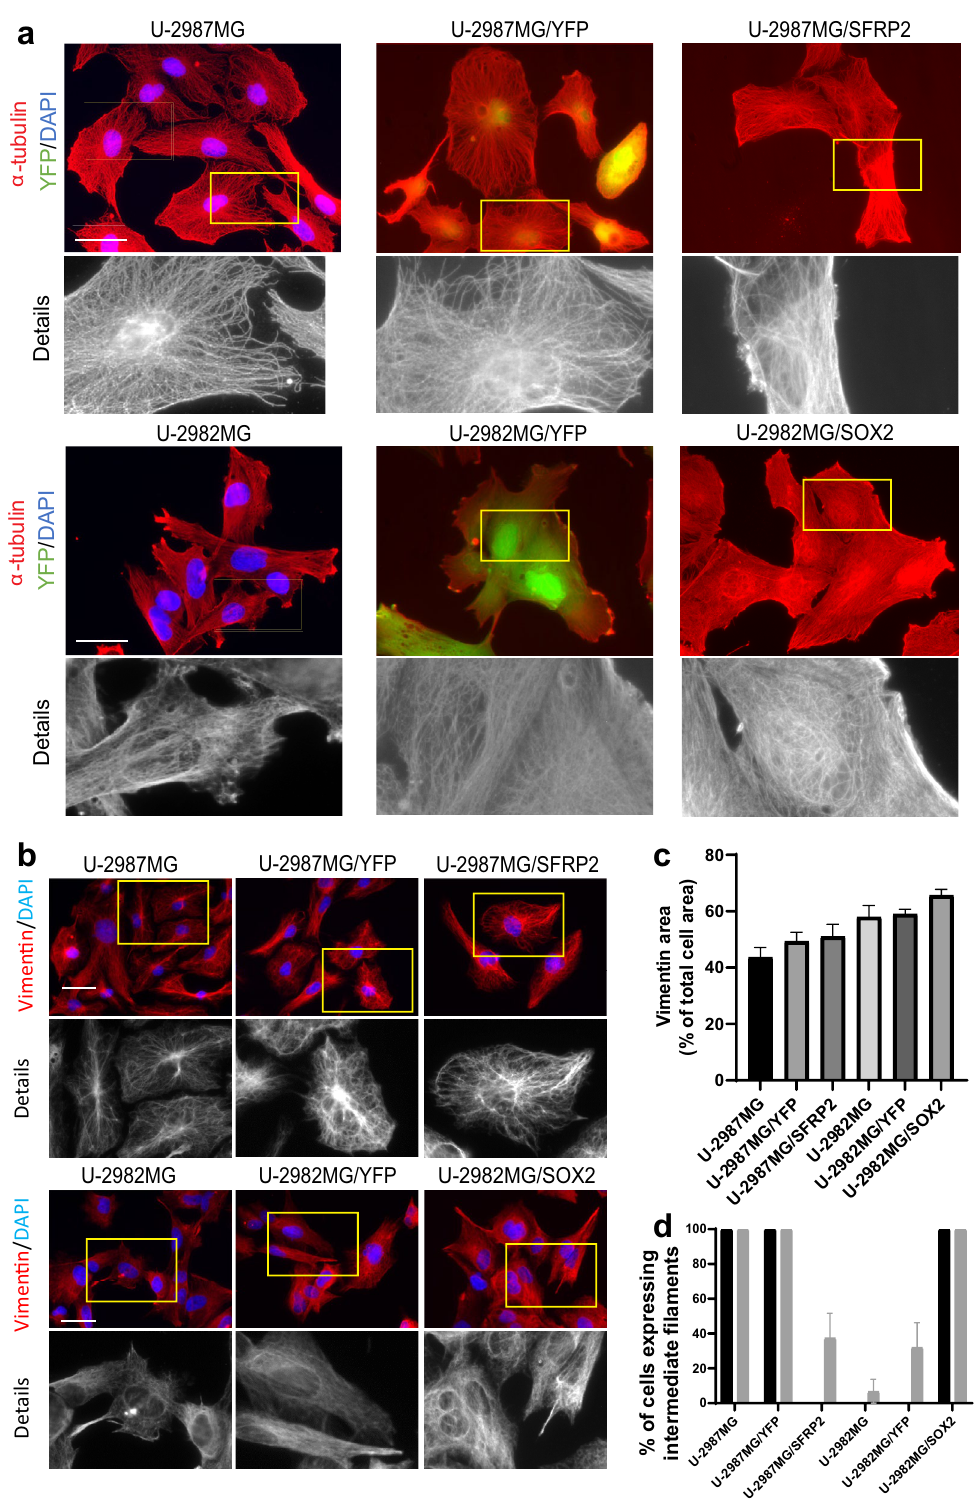
Figure 5. α-tubulin and vimentin organization in cell lines U-2982MG/SOX2 and U-2987MG/SFRP2. ( a ) Representative images of α-tubulin organization, as stained with rabbit anti–α-tubulin antibodies and AMCA-conjugated donkey anti- rabbit antibodies. ( b ) Representative images of vimentin organization, as stained with mouse anti-vimentin antibodies and AlexaFluor568-conjugated goat anti-mouse antibodies. Scale bars, 50 µm (A, B). ( c ) Quantification of the proportion (%) of the area of the cell occupied by vimentin. Quantification was performed from three independent experiments using ImageJ, and statistical significance was calculated with ANOVA-Tukey’s post-hoc tests and summarized in Supplementary Table S10. ( d ) Quantification of the proportion (%) of cells expressing GFAP and nestin. Quantification was performed from three independent experiments per cell line. Statistical significance was calculated with ANOVA-Tukey’s post-hoc tests and summarized in Supplementary Table